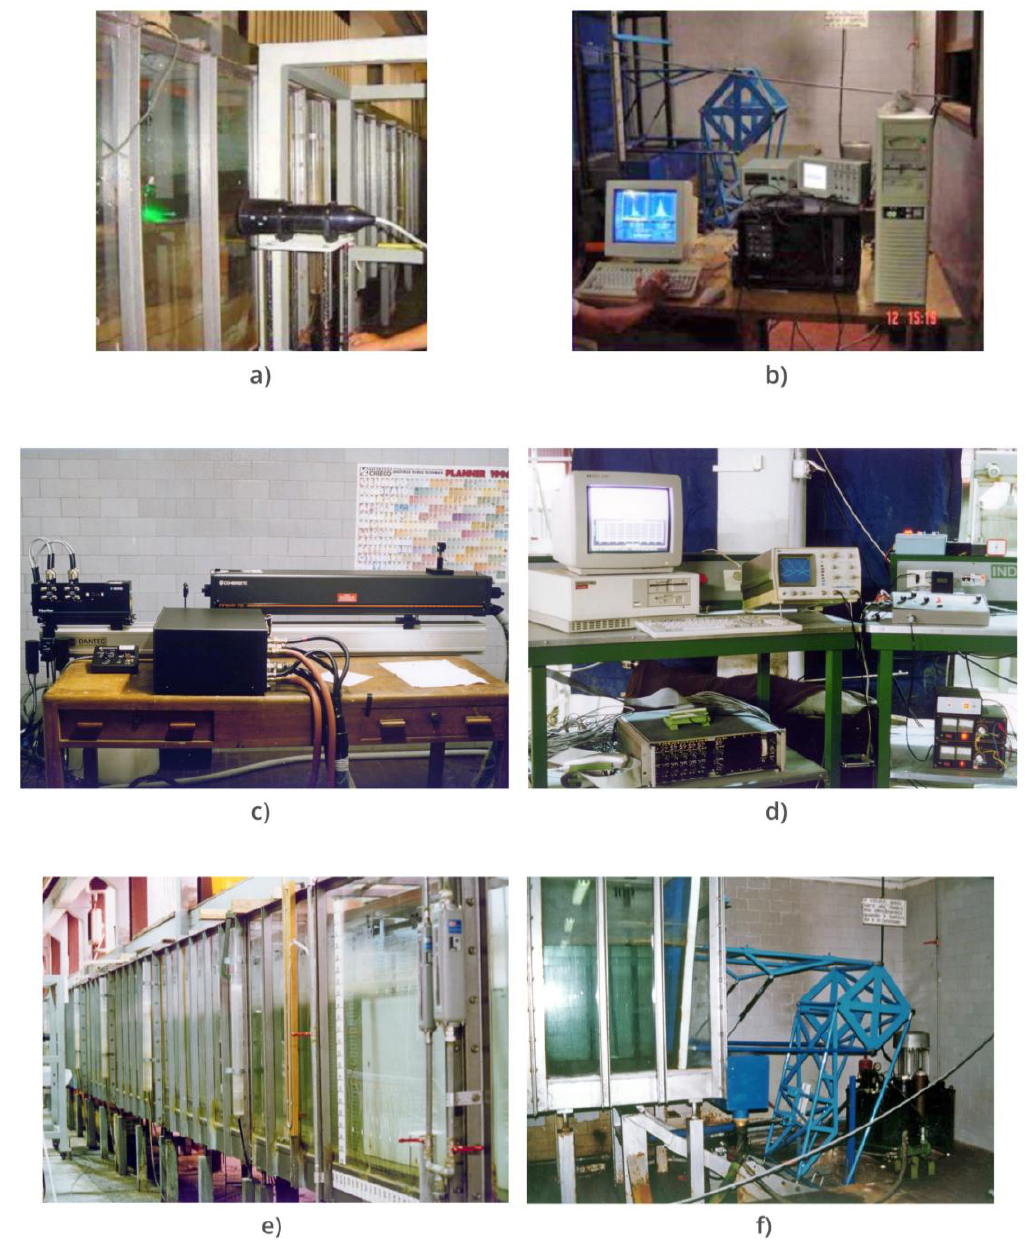
Figure 5. Experimental apparatus: ( a ) LDA probe; ( b ) Dantec FVA signal processor and process computer; ( c ) Laser Coherent Innova and Dantec 2D Fibre Flow optics; ( d ) process computer with an AD/DA board for the wavemaker control; ( e ) a part of the wave channel where the jets were discharged; ( f ) the wavemaker.